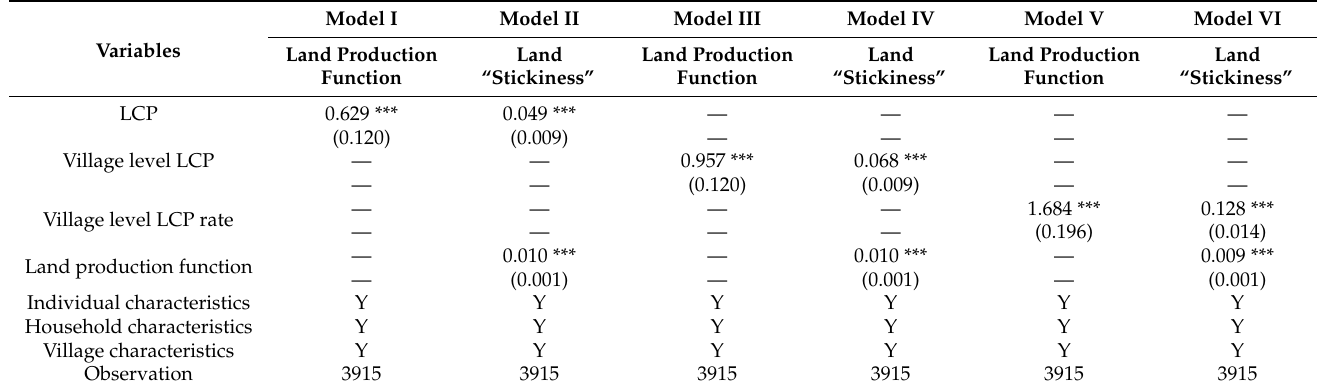
Table 9. Results of the test for mediating effects of land production